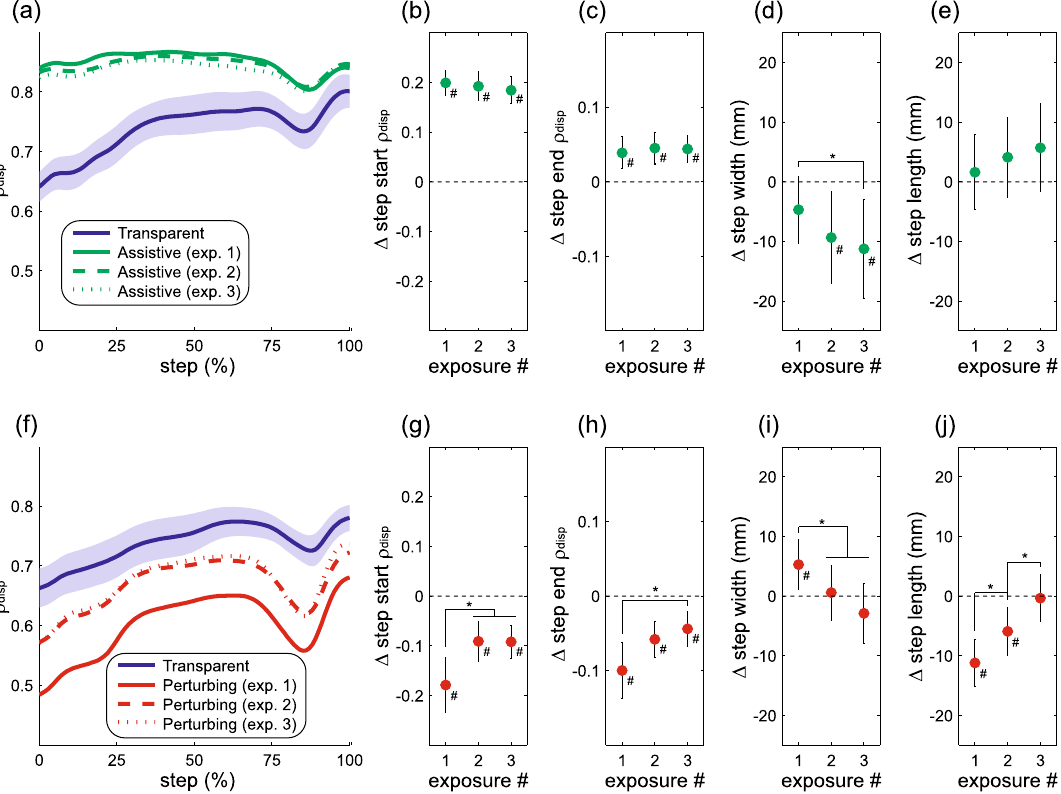
Figure 6. Effects of repeated exposure to the force-field. Following the structure of Fig. 3, the top row ( a – e ) illustrates the direct effects of force-field assistance, while the bottom row ( f – j ) illustrates the direct effects of force-field perturbations. As in previous figures, ρ disp represents the partial correlation between pelvis displacement and step width. For these comparisons, the first 225 steps of each exposure are included. Asterisks (*) indicate significant differences between the indicated exposures. Pound signs (#) indicate a significant difference from the initial Transparent